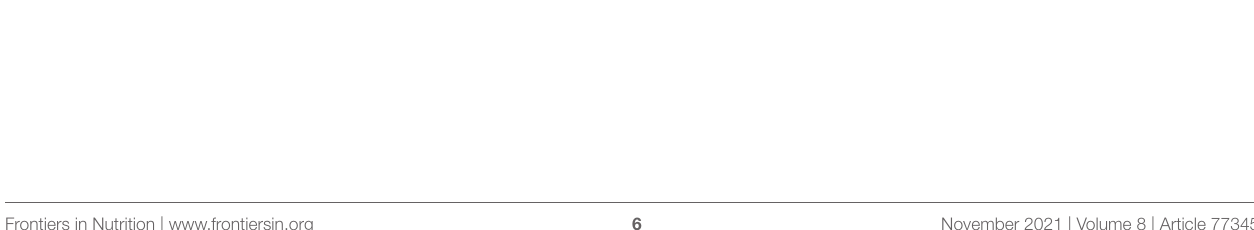
Frontiers in Nutrition |